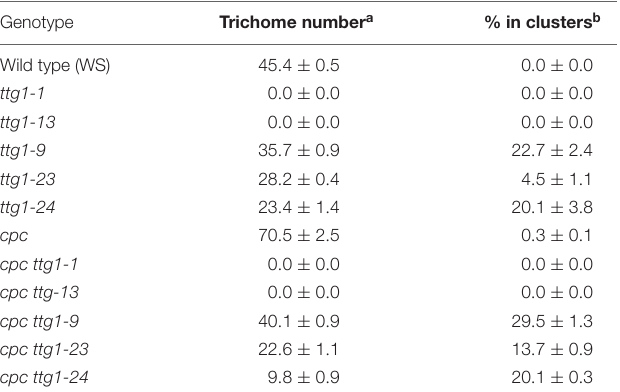
FIGURE 4 | TTG1-related phenotypes in WT, ttg1-23 , ttg1-24 , and ttg1-13 . (A) Proanthocyanidin accumulation in the seed. Bar = 1 mm. (B) Anthocyanin accumulation in the hypocotyl of 3-day-old seedlings. Bar = 10 mm. (C) Trichome production on one of the first true leaves. Bar = 2